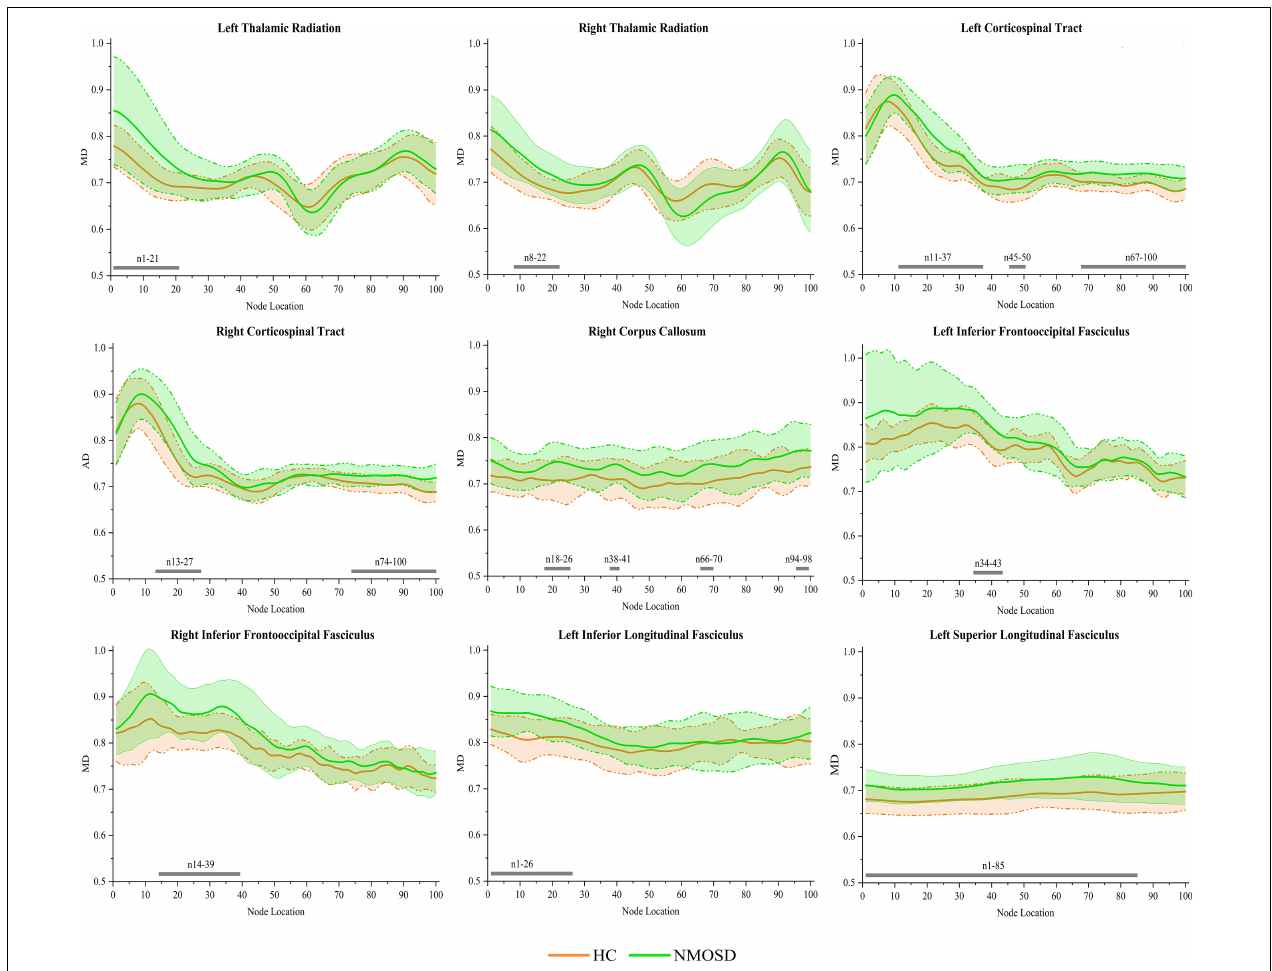
FIGURE 4 | Group differences in pointwise white matter (WM) fiber tracts of mean diffusion (MD) between NMOSD and healthy control [HC; p < 0.05, false discovery rate (FDR) correction]. The green line represents the NMOSD group, and the orange line represents the HC group (solid lines for means and shaded regions for standard deviations). The gray bars at the bottom are the location of the fiber nodes with significant differences between the two